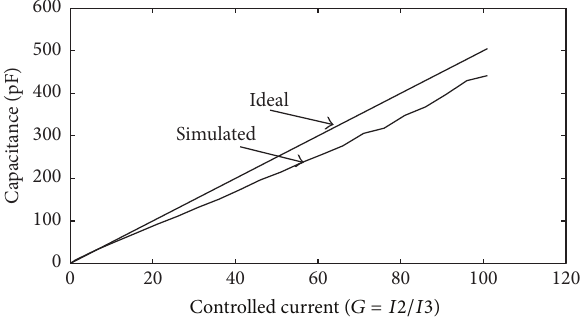
Figure 4: Plot of simulated capacitance and ideal case.